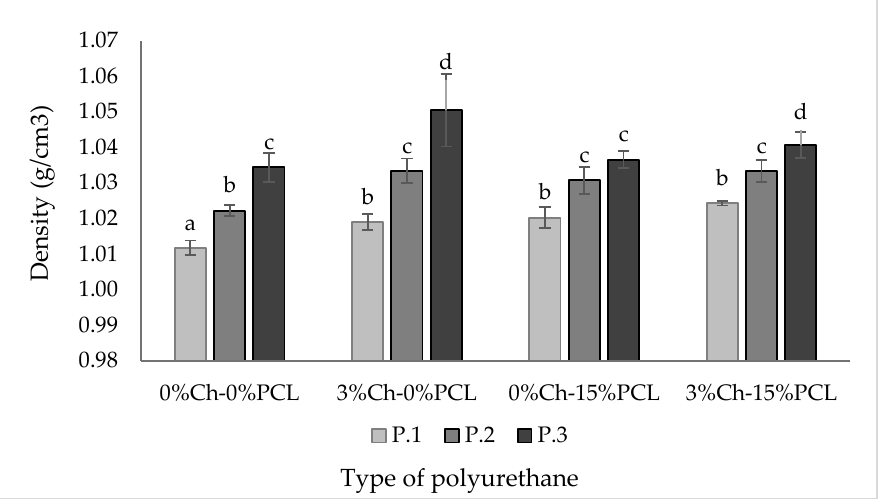
Figure 6. Density of the synthesized PUs. The data are expressed as the mean ± SD (n = 3). Bars with different letters (a–d) indicate significant differences ( p < 0.05).